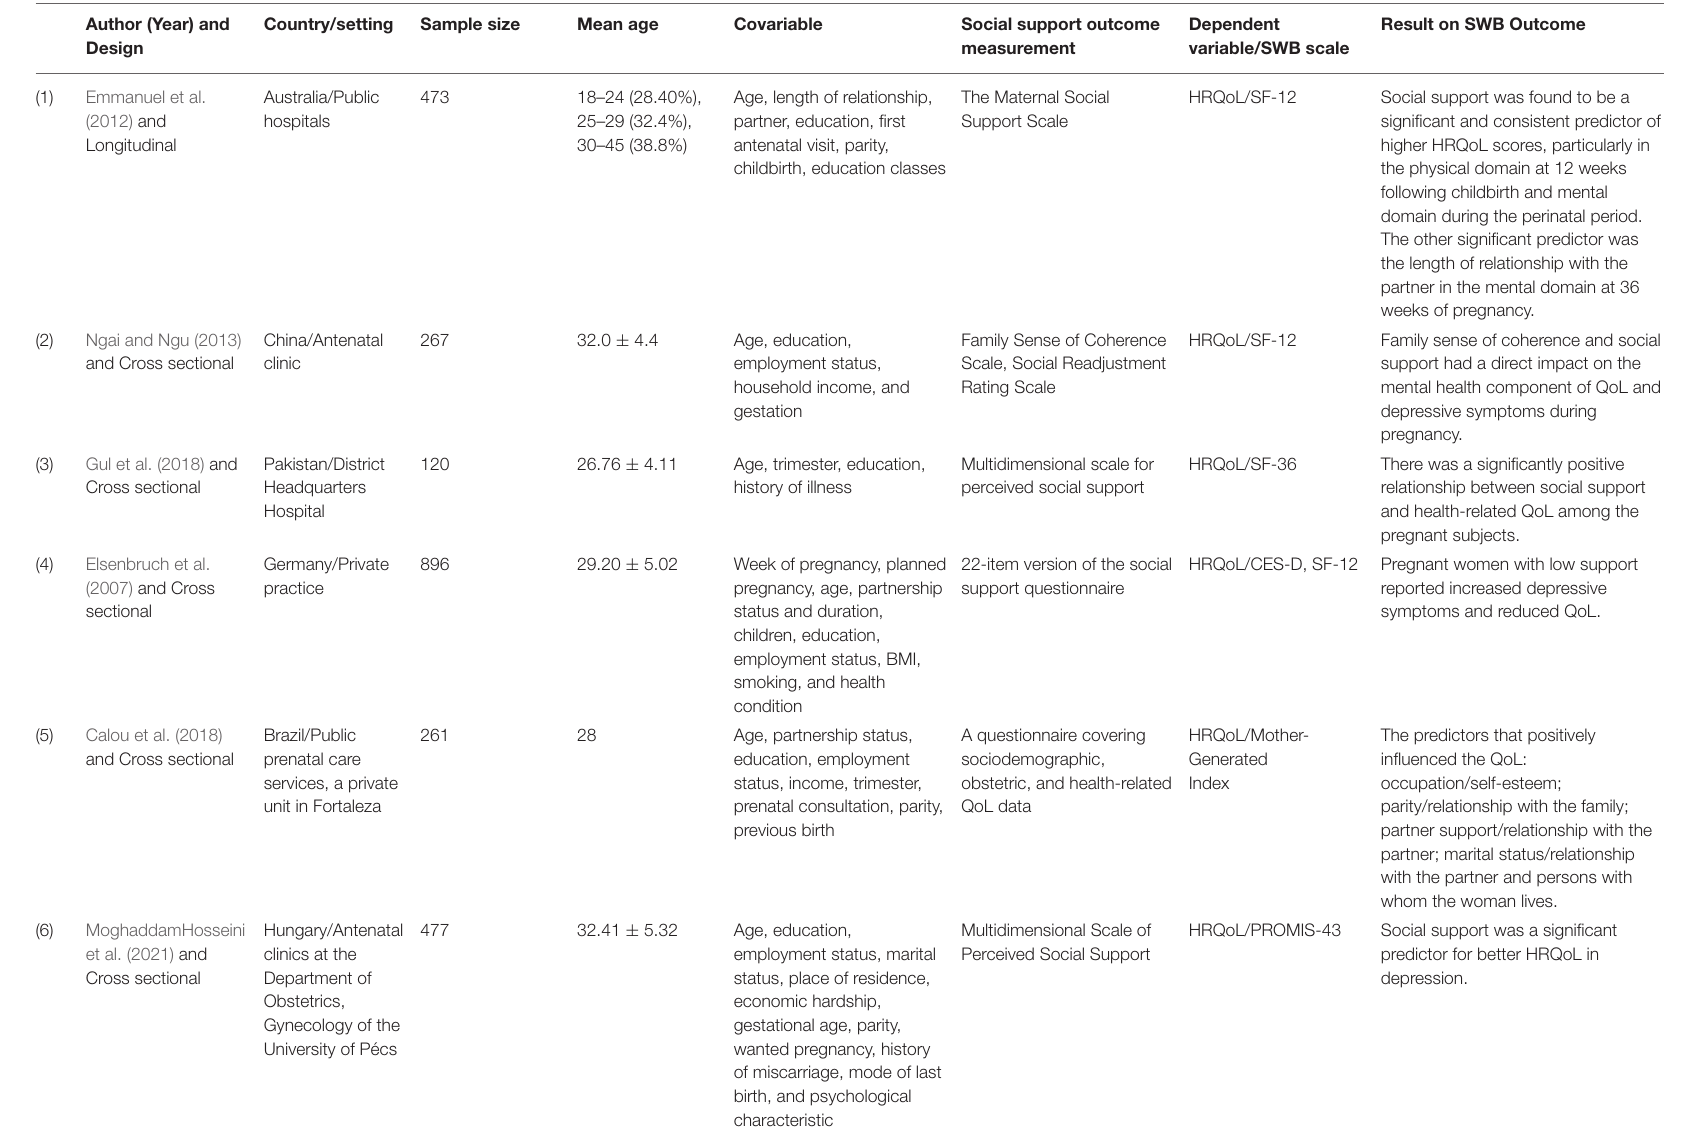
TABLE 3 | The effect of social support (SS) on SWB among pregnant women. Author (Year) and